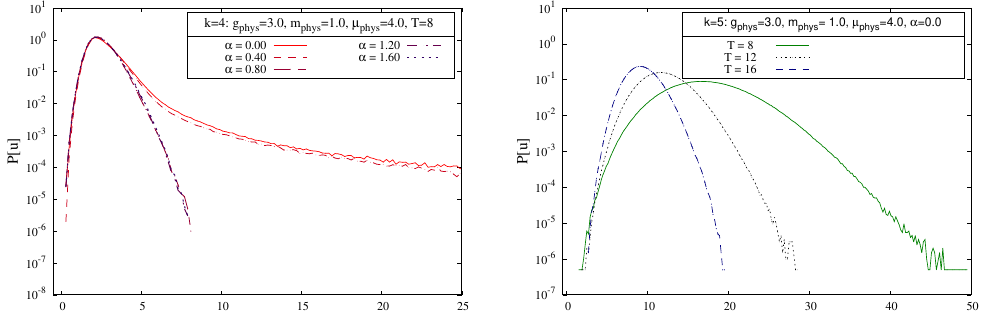
Figure 14 . (Left) Decay of the drift term for various α values for the model with even-degree ( k = 4 ) polynomial potential on a T = 8 lattice. The parameters used are g phys = 3 , m phys = 1 , and µ phys = 4 . 0 . (Right) The decay of the drift terms for the model with odd-degree ( k = 5 ) real polynomial potential on T = 8 , 12 , 16 lattices. The parameters used are g phys = 3 , m phys = 1 , and µ phys = 4 . 0